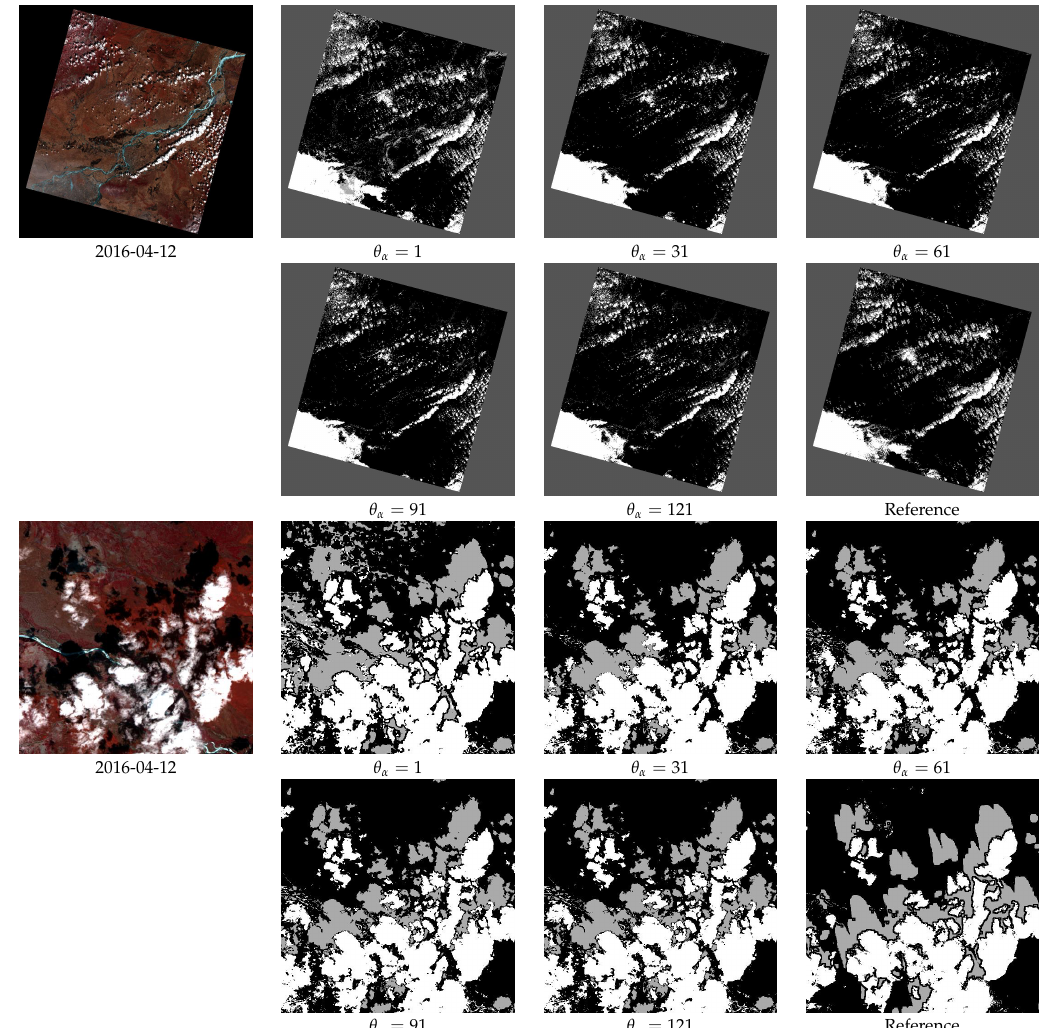
Figure 10. visualizations with regards to θ α of Dense CRF postprocessing. The candidate values of θ α vary from 1 to 121 while θ β and θ γ are secured to 11 and 3. Isolated regions can be removed if a higher θ α is